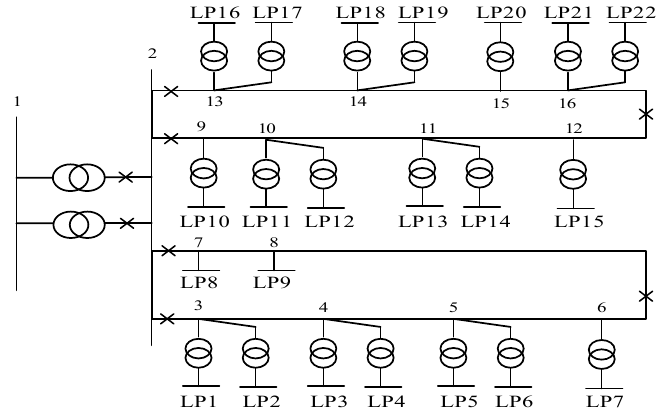
Figure 5. Test system configuration of the IEEE RBTS distribution section .